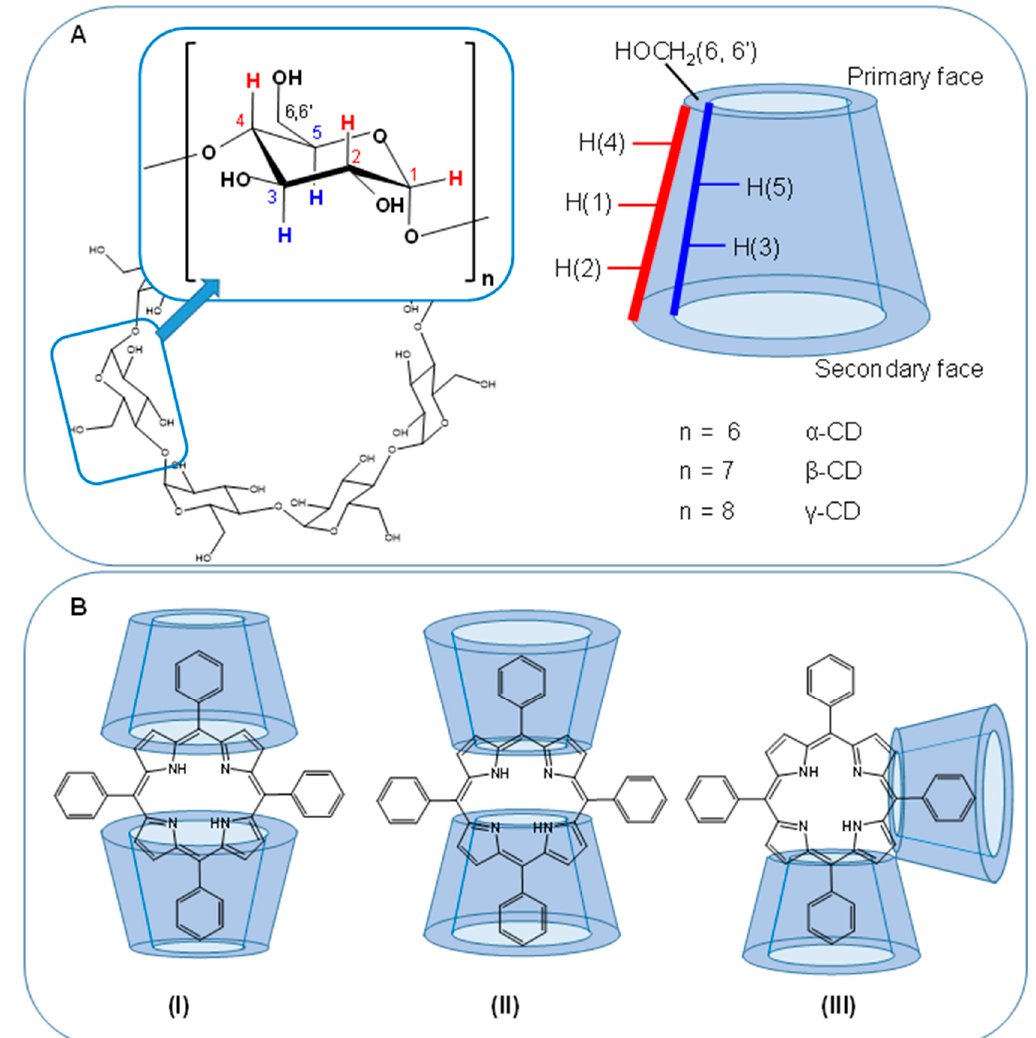
Figure 8. ( A ) Structure of cyclodextrin and the α -1,4- D -glucopyranose unit with atom numbering; sketch of the cone-shaped structure of CDs in which the protons H(3) and H(5) point to the hydrophobic interior of the cavity (blue), the protons H(1), H(2) and (H4) point to the hydrophilic exterior (red), and the protons H(6,6 ′ ) are located at the rim of the primary face. ( B ) Examples of possible 2:1 inclusion complexes formed with tetraphenylporphyrins (TPPs): ( I ) inclusion via secondary face, ( II ) inclusion via primary face, opposite (anti) conformation, and ( III ) complex with adjacent (syn) conformation.